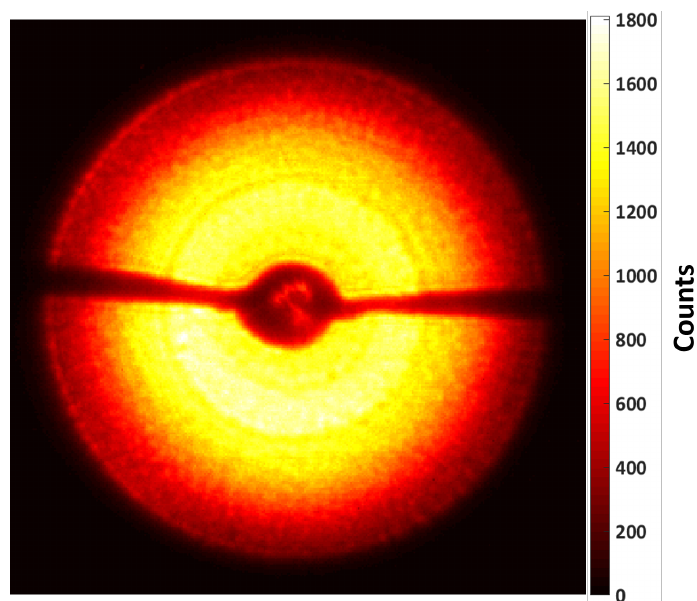
Figure 5. Raw image of the first order diffraction cone showing a map of the local zone plate